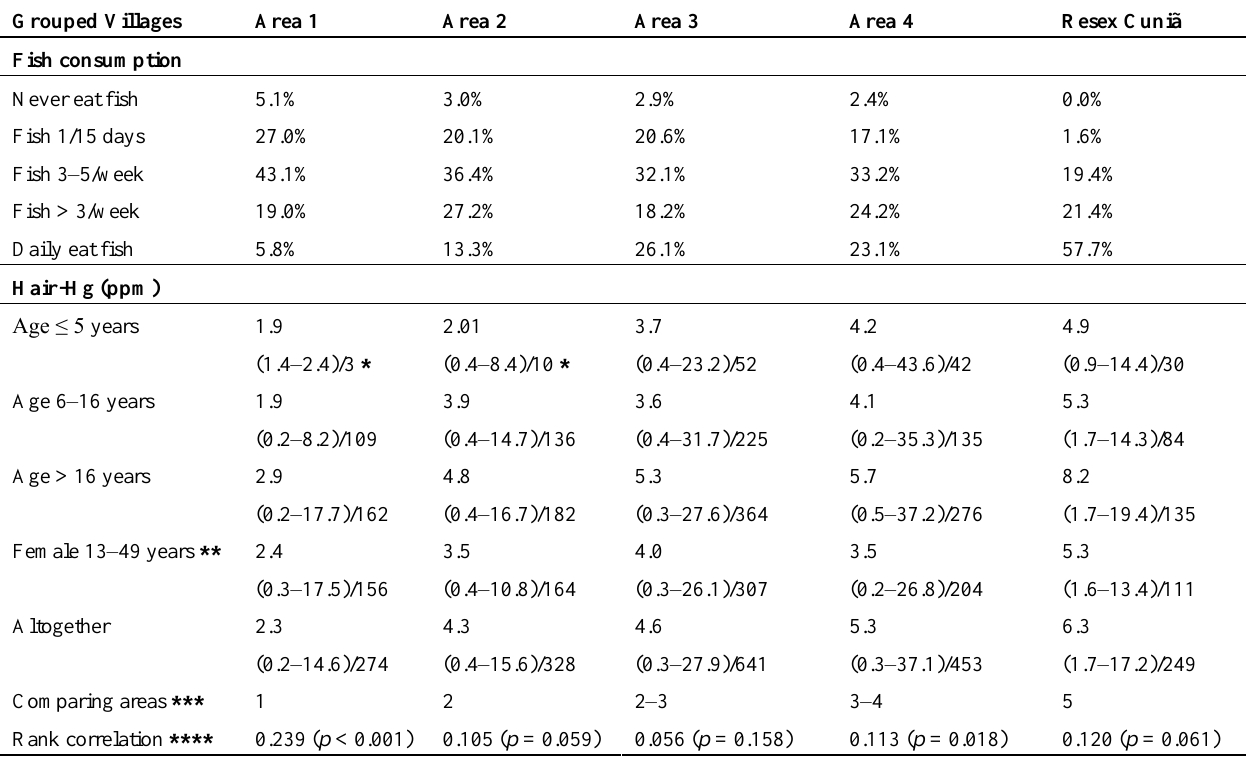
Table 2. Regular fish consumption and total-Hg concentration in riparians’ hair from Madeira River